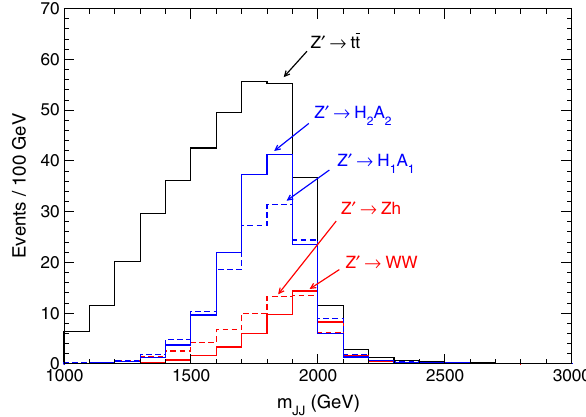
= 80GeVand g = 0 . 3,usingtan β = 2and v GeV, m H Z (cid:2) 1 , A 1 GeV. Right: The same, but for the decay A 2 → A 1 H 1 and for different | 2 . The values of the doublet pseudoscalar component of the SM singlet-like H 2 H d = 200 | 2 pseudoscalar A 2 , | Z H A 2 A d 2 , A 2